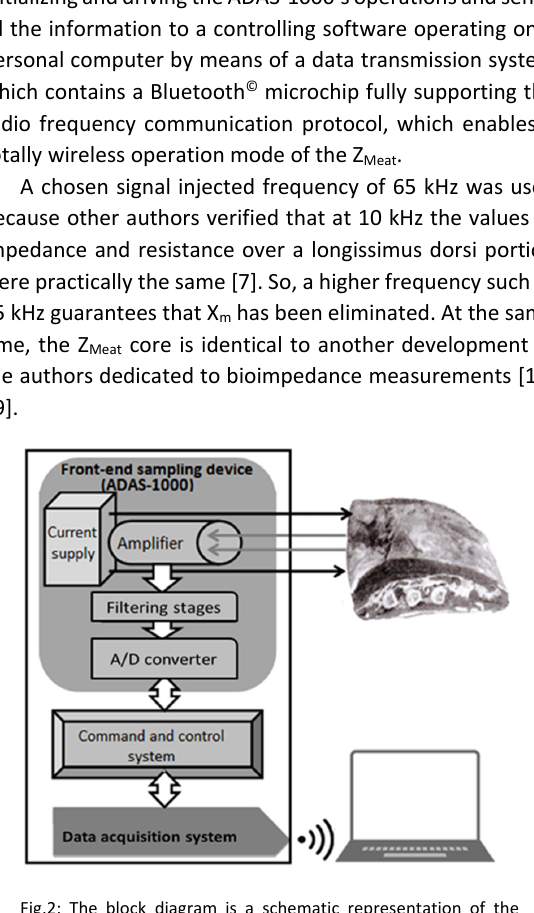
Fig.2: The block diagram is a schematic representation of the electrical components in the device Z Meat .